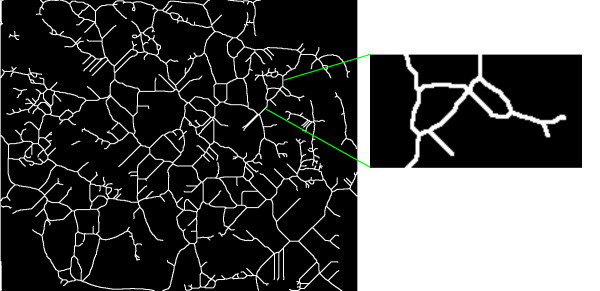
Skeleton of the segmented image in Figure 1. The magnified section (right) shows two loops, 11 links (three of them connected to nodes outside of the field of view), three branches, seven nodes, and three endpoints.